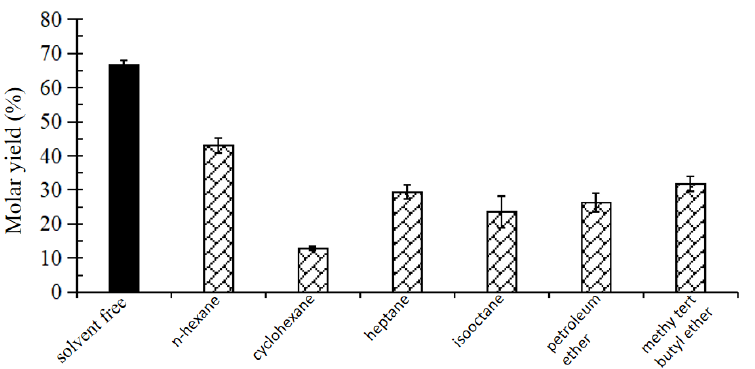
Figure 7. E ff ect of solvent system on the yield of isopropyl myristate synthesized by adsorp- Figure 7. Effect of solvent system on the yield of isopropyl myristate synthesized by adsorption/cross- tion/cross-linking immobilized KDN Lipase. linking immobilized KDN